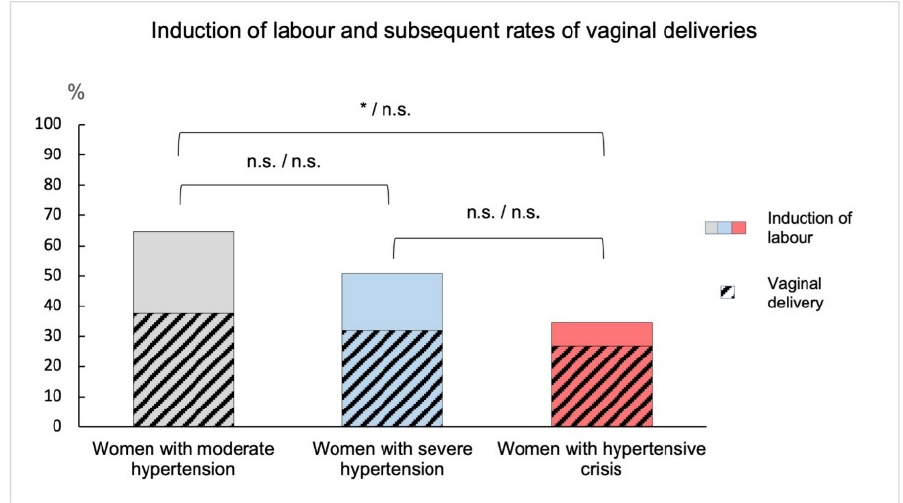
Figure 1. Induction of labour and subsequent rates of vaginal deliveries in women with preeclampsia. The rates of induction within the three blood pressure groups and resulting proportion of vaginal deliveries are shown. Induction of labour was significantly more frequent in women with moderate hypertension compared to women with hypertensive crises (* = p = 0.03), all other comparisons are not significant